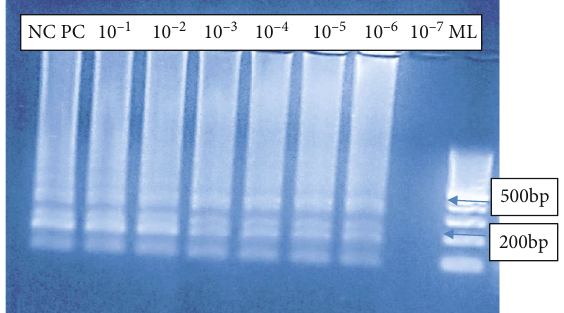
Figure 5: LAMP sensitivity testing on gel electrophoresis. Lane NC represents negative control; lane PC represents positive control; lanes 10 − 1 – 10 − 6 represented serial dilutions of DNA extracts for testing the assay sensitivity. 10 − 1 – 10 − 6 showed ampli fi cation of W. bancrofti as bands appeared at di ff erent lengths indicating that our LAMP assay was sensitive and could detect to up to 1/1000000 (1/10 6 ) DNA copies of the parasites in the diluent, while no band was observed in 1/10000000 (1/10 7 ) copies in the